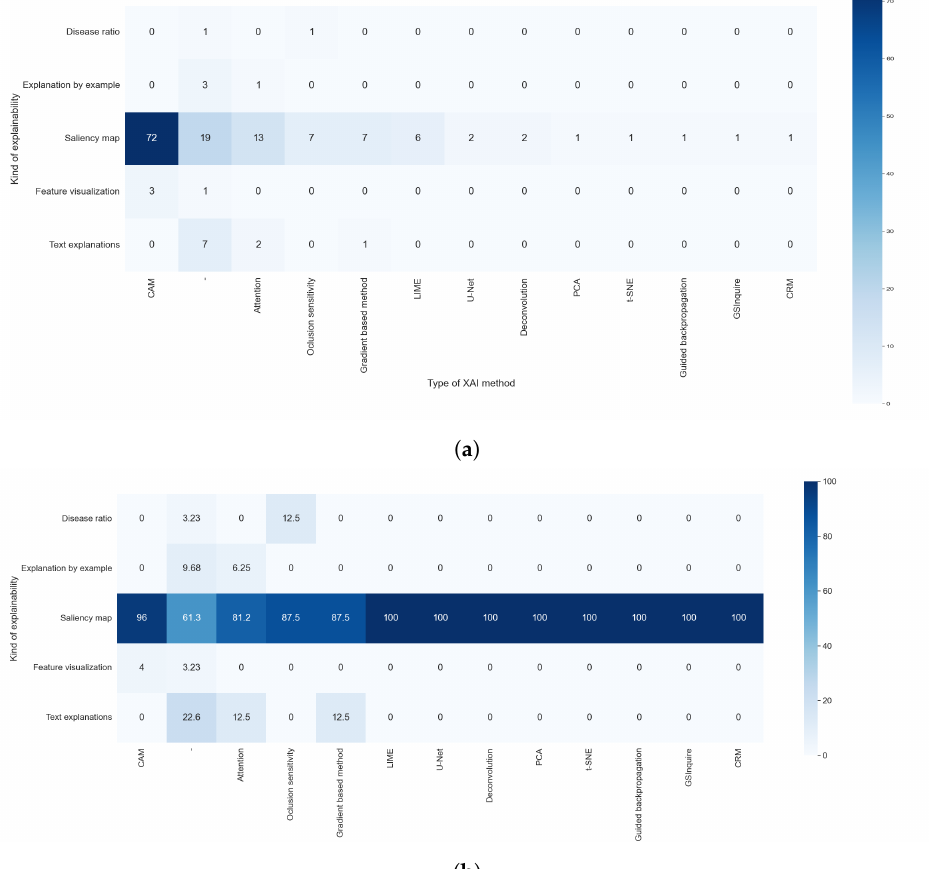
Figure 19. Heat maps comparing the results of RQ5 and RQ7. ( a ) In absolute values; ( b ) normalized results by column, values in